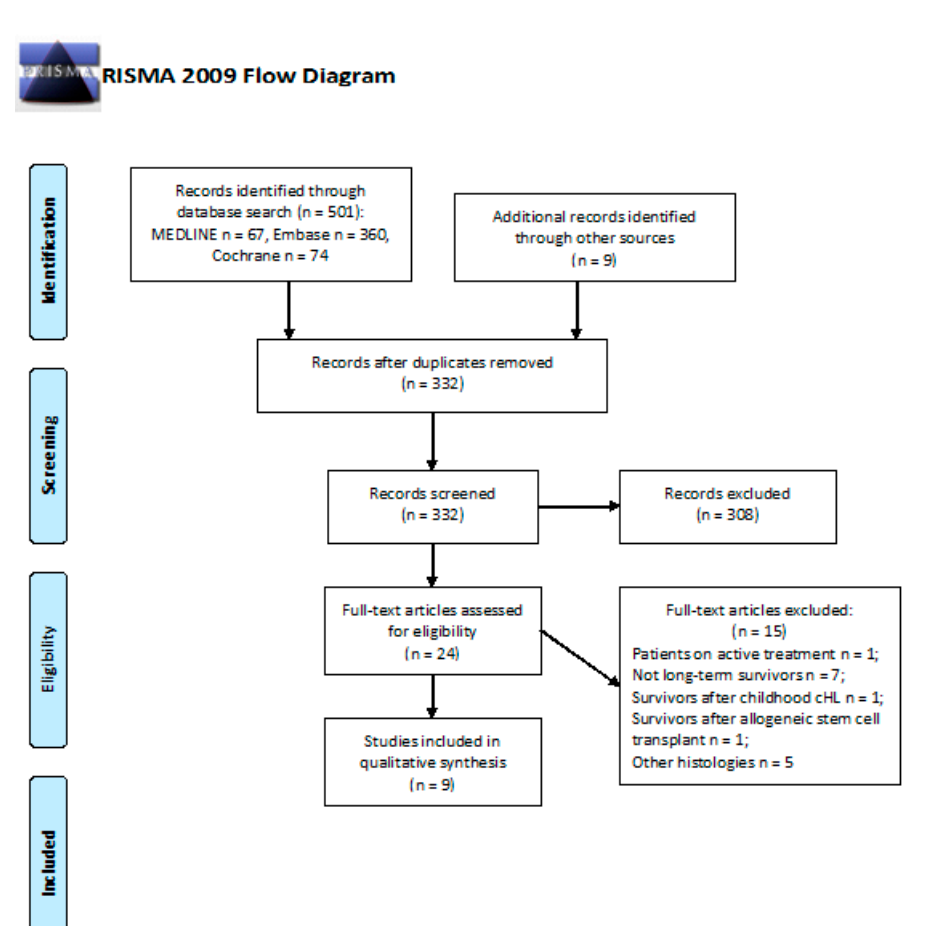
Figure 3. PRISMA flow diagram on the incidence of cognitive impairment.